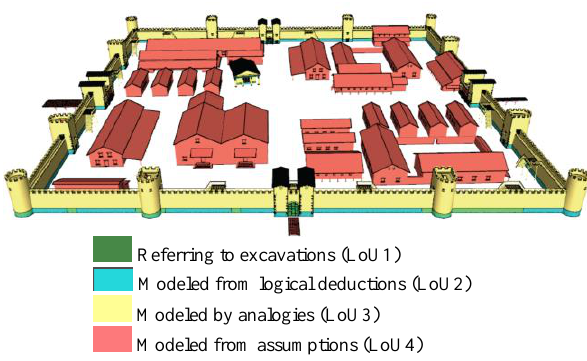
Figure 11: Uncertainty visualization based on four levels of uncertainty (LoUs). Case of the castellum of Horbourg-Wihr, Alsace.